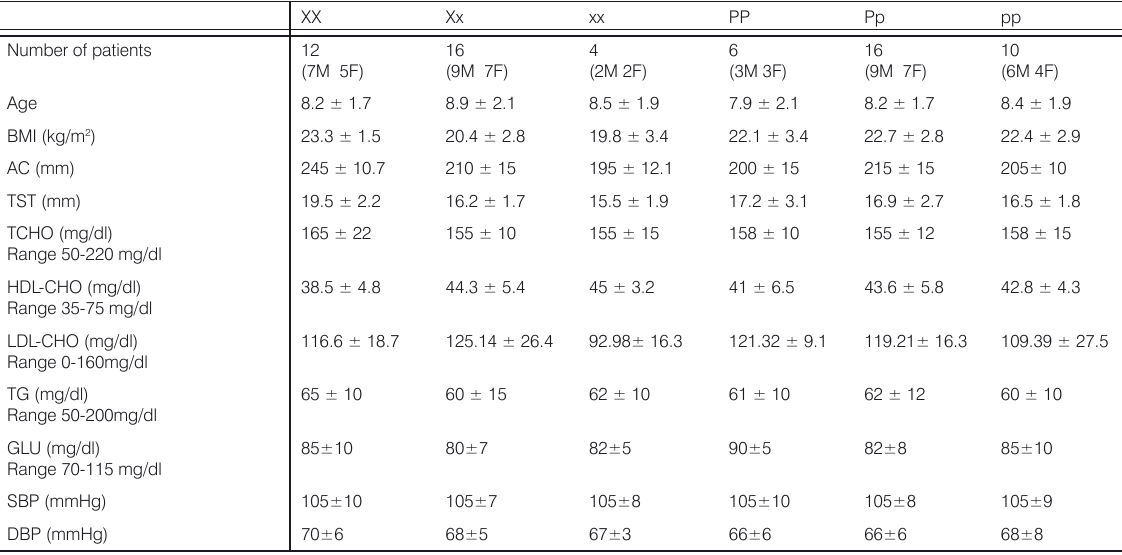
Table 2. Anthropometric, metabolic and blood pressure values in children with Down Syndrome belonging to various ER genotypes.